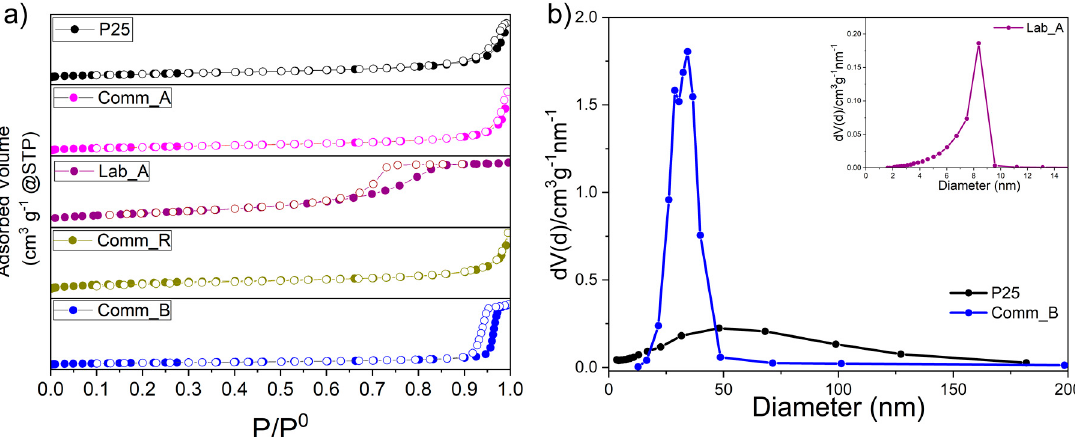
Figure 3. ( a ) N 2 adsorption/desorption isotherms at − 196 °C on the studied powder samples.Full and empty symbols refer to adsorption and desorption run, respectively. ( b ) Pore Size Distribution of the P25, Comm_B, and Lab_A samples, as obtained by applying the BJH method to the isotherms desorption branch. Table 1. Some relevant textural and surface properties of the studied powder samples as obtained by XRD followed by a Rietveld refinement, b N 2 isotherms at − 196 °C, c EDX elemental analysis, d XPS elemental analysis, and e electrophoretic measurements.